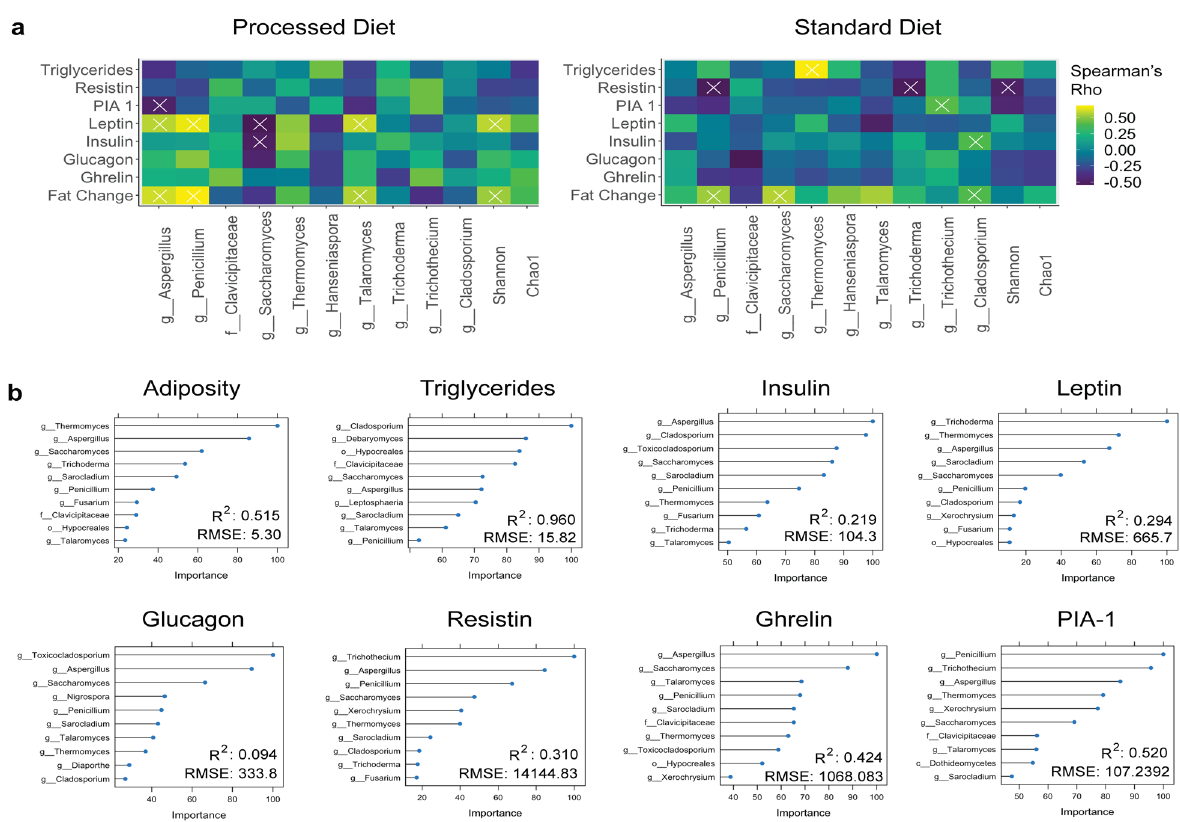
Fig. 7 Fungal genera strongly associate with metabolic tone. a Biconjugate A-Orthogonal Residual method. X indicates p < 0.05 after false discovery rate correction. b Random forest regression models showing the relative importance of a particular taxon to the model. PIA-1 plasminogen activator inhibitor-1, R 2 correlation coef fi cient, RMSE root mean square